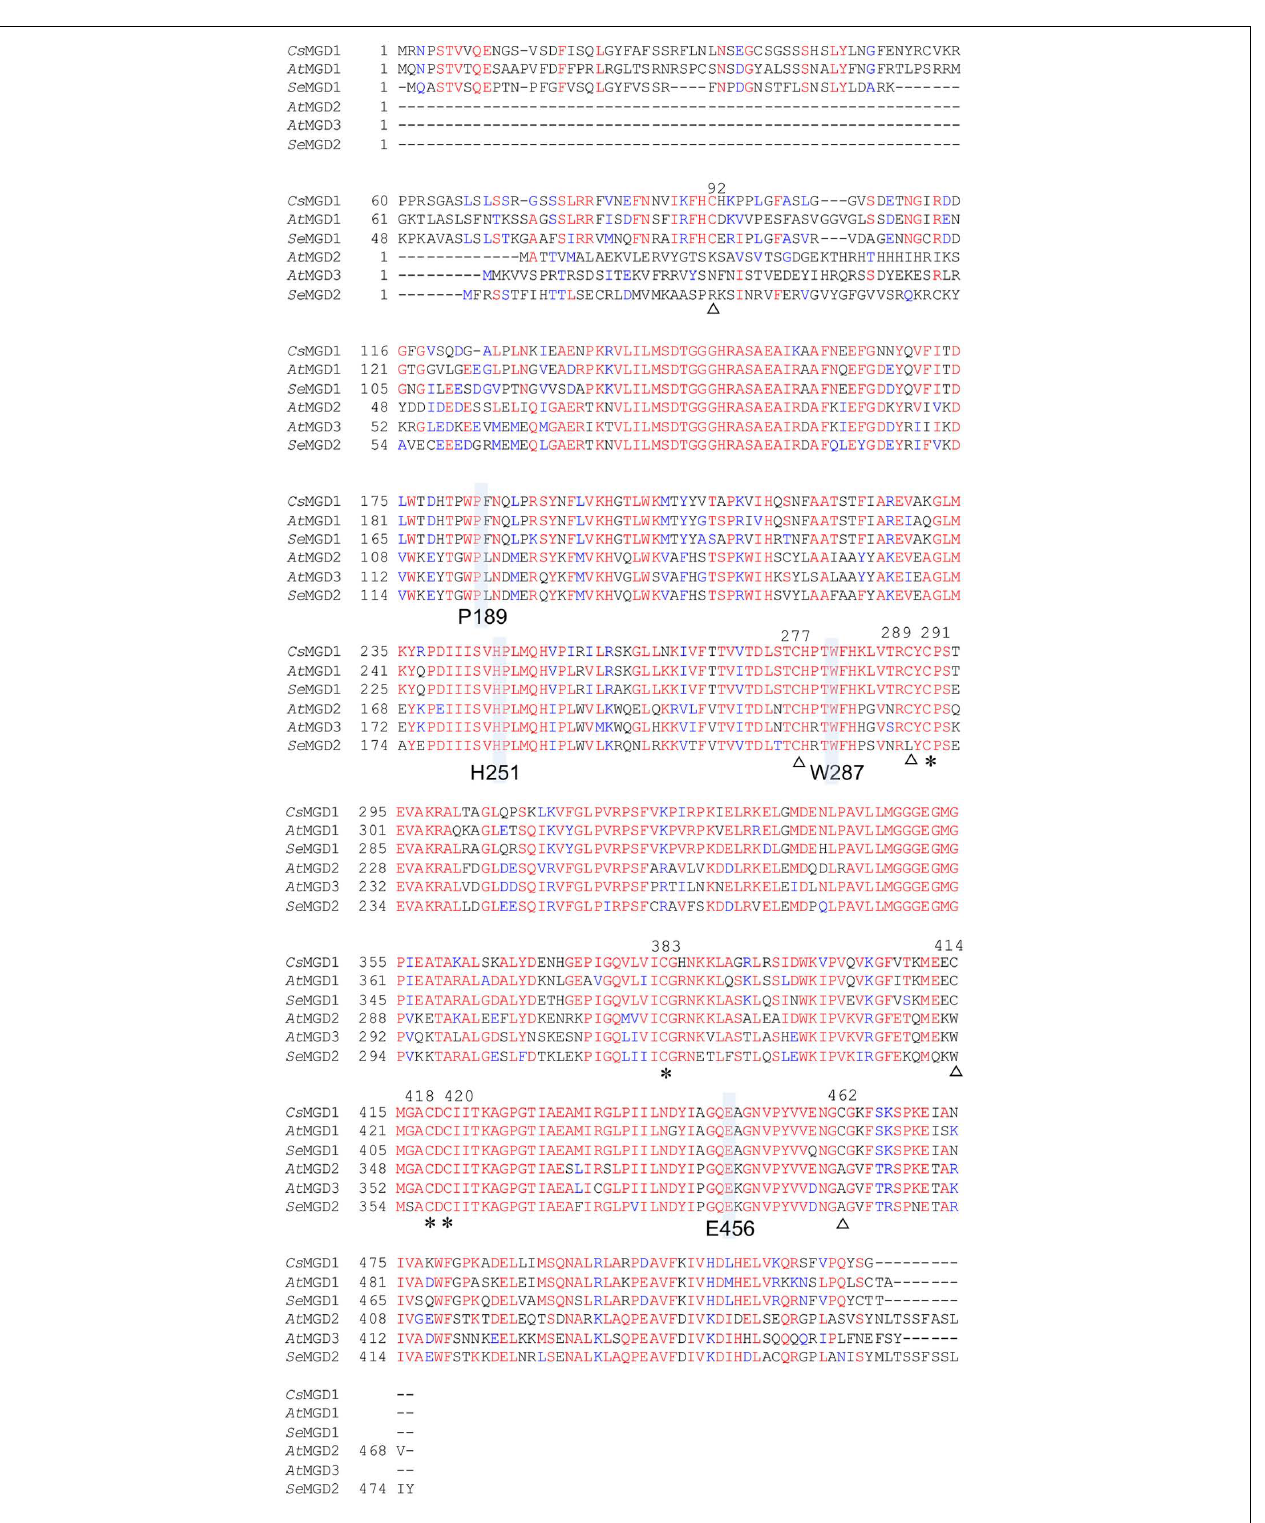
FIGURE 3 |Amino acid sequence alignment for MGDG synthases. Red and blue indicate conserved and similar residues, respectively. Identical cysteines are indicated by asterisks; partially conserved cysteines are indicated by open triangles. Four residues in At MGD1 (P189, H251,W287,